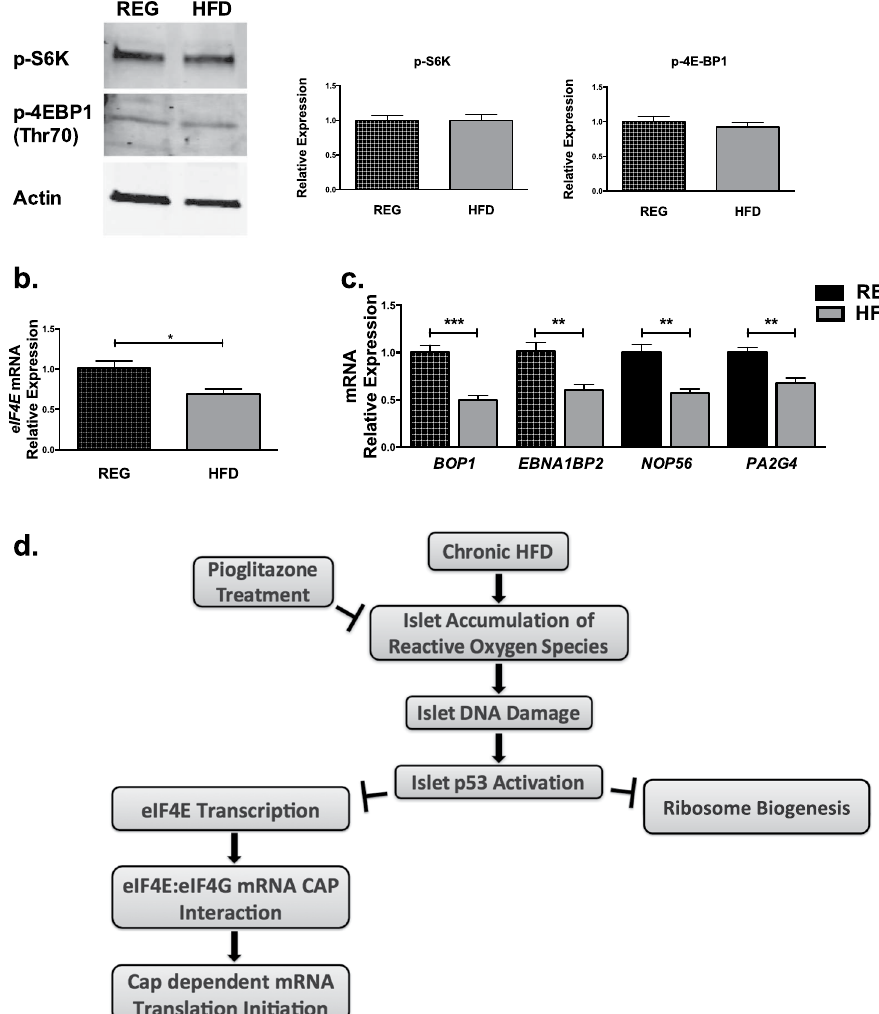
Figure 7. Mechanisms of HFD effects on β cell mRNA translation. ( a ) Immunoblots for phosphorylated S6 kinase at T389 (p-S6K) and phosphorylated eIF4E binding protein 1 at T70 (p-4E-BP1) in islets from mice on regular diet and HFD. ( b ) q-PCR evaluating relative expression of eIF4E transcripts. ( c ) q-PCR evaluating relative expression of ribosome biogenesis genes BOP1, EBNA1BP, NOP56 , and PA2G4 . n = 3–4; * p < 0.05, ** p < 0.01, *** p < 0.001. ( d ) Proposed mechanisms of HFD-induced reductions in β cell